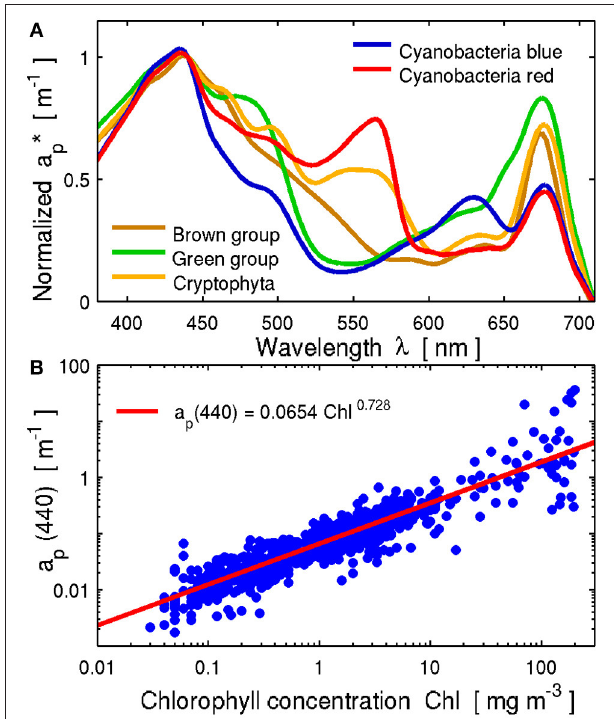
FIGURE 2 | Bio-optical model of phytoplankton absorption. (A) , Fundamental absorption spectra of five algae groups. (B) , Modelled variability of the absorption coefficient of phytoplankton at 440 nm as function of chlorophyll concentration. The solid line shows the regression line of observations (Bricaud et al.,